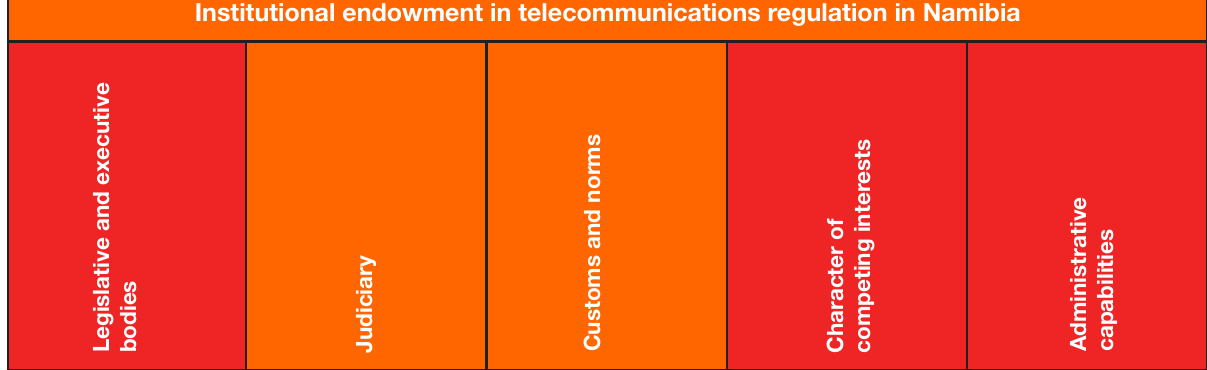
FIGURE 2: PERCEPTIONS OF EFFECTIVENESS OF THE INSTITUTIONAL ENDOWMENT Institutional endowment in telecommunications regulation in